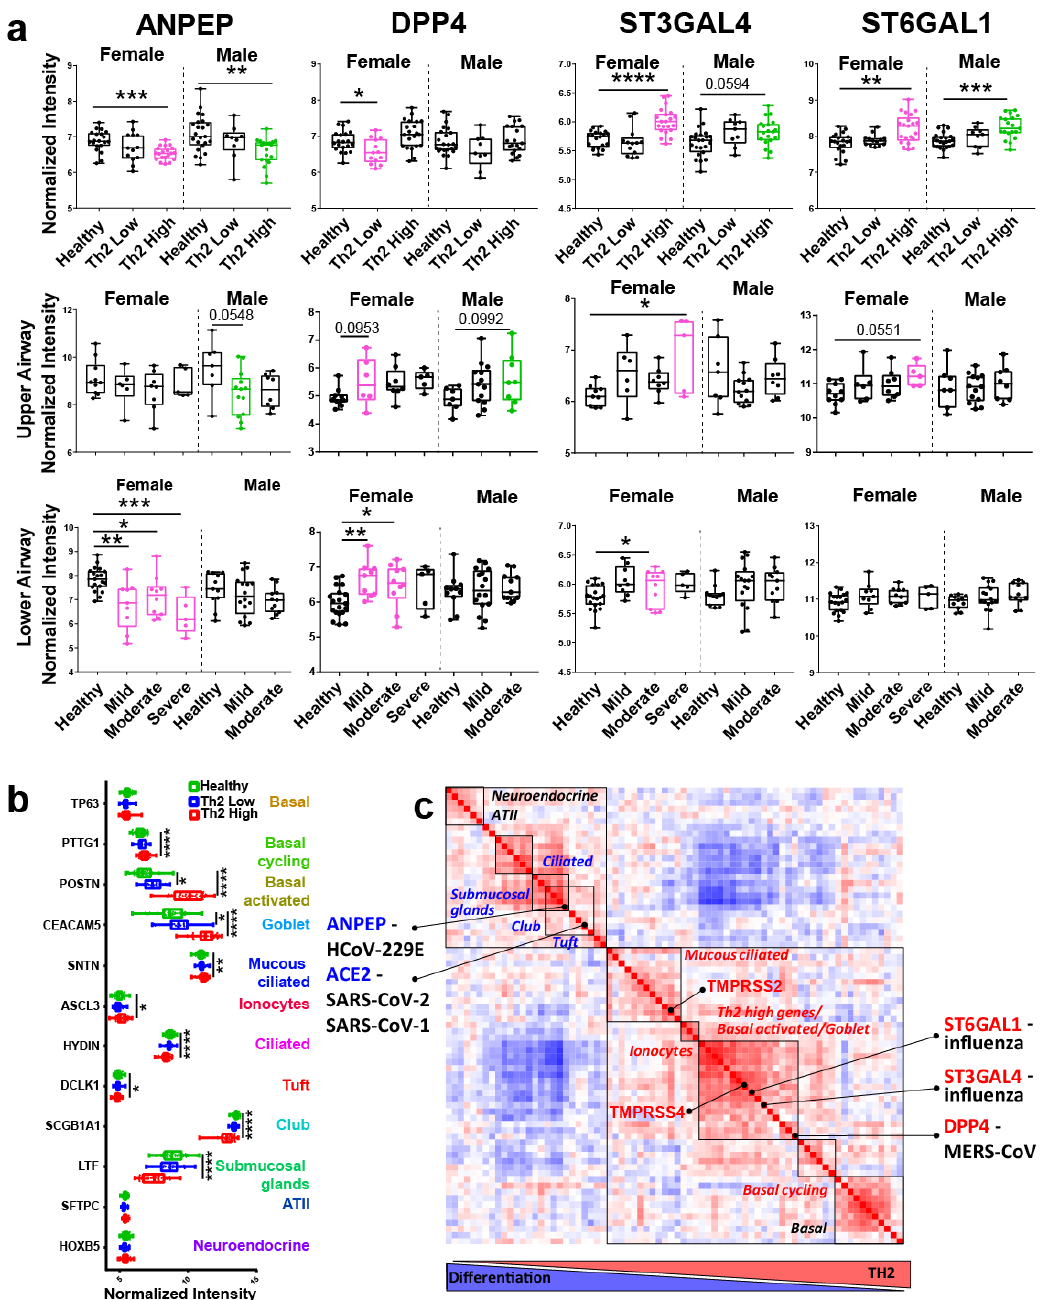
Figure 2. A comparative analysis of human coronavirus and influenza entry genes in Th2 high inflammation. ( a ) Box and whisker plots showing normalized gene expression intensity values of several viral species in healthy and asthmatic samples broken down by sex. Top row compares healthy ( n = 20 Female, 23 Male), Th2 low ( n = 13 F, 9 M), and Th2 high ( n = 2 F, 19 M) asthma. Middle row compares healthy ( n = 10 F, 7 M), mild ( n = 6 F, 13 M), moderate ( n = 8 F, 8 M), and severe ( n = 5 F) asthma in the upper airway. Bottom row compares healthy ( n = 19 F, 11 M), mild ( n = 9 F, 16 M), moderate ( n = 10 F, 11 M), and severe ( n = 5 F) asthma in the lower airway. ( b ) Box and whisker plots showing normalized intensity values of key epithelial subset marker genes in healthy, Th2 low, and Th2 high asthma patients. ( c ) , similarity matrix demonstrating unsupervised hierarchical clustering of SARS-CoV-1, SARS-CoV-2, HCoV-229E, MERS and influenza entry genes together with top epithelial subset genes from a study by Vieira Braga et al. [8] Higher levels of Th2 inflammation are associated with lower levels of epithelial differentiation (diagram below matrix). Significance in ( a ) . was calculated using ANOVA with Tukey post-hoc analysis. All data points are shown in the box and whisker plots, and the box represents the second and third quartiles and median. * p < 0.5, ** p < 0.01, *** p < 0.001, **** p <